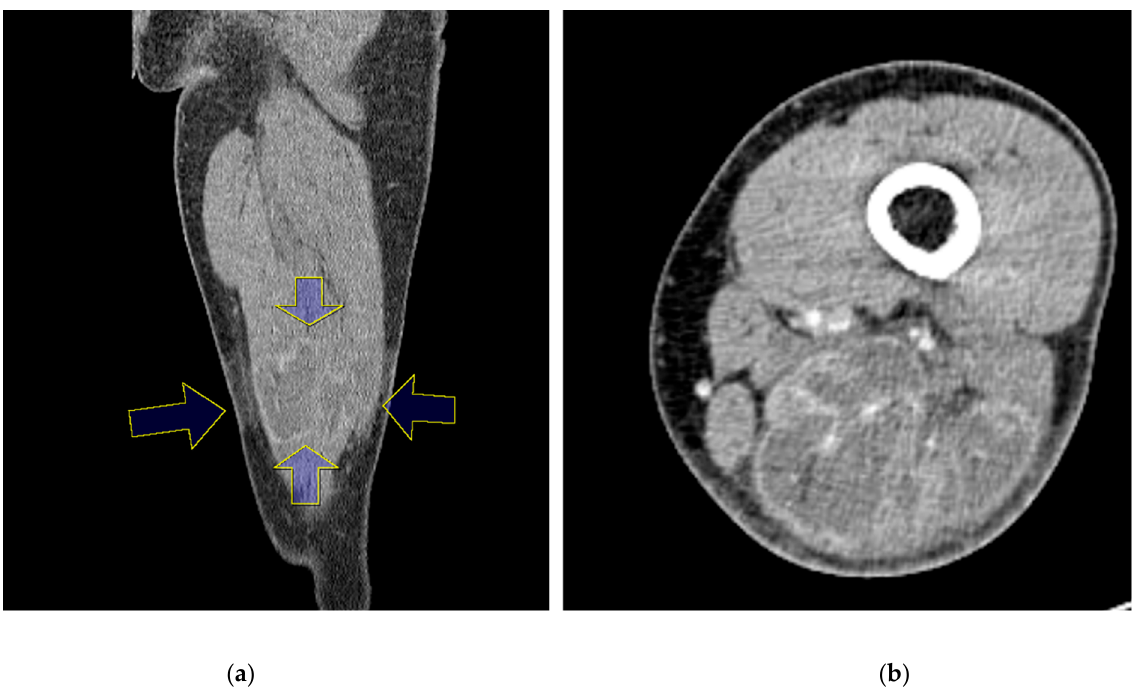
Figure 2. Computed tomography (CT) scan with contrast reveals ischemic changes in the adductor magnus, biceps femoris long and short head, semimembranosus, and semitendinosus muscles from 25 cm below the femoral head (blue arrow) in coronal view( a ) and axial view( b ). During outpatient follow-up, the patient’s foot drop showed no significant improve- ment, the sensory deficit was sustained, and severe tenderness with a visual analog scale (VAS) score of 7 was observed, along with a palpable mass in the posterior aspect of the left thigh. Despite conservative treatment, there was no improvement in pain or motor and sensory function. In addition, apparent muscle necrosis and sciatic neuropathy were observed in the imaging study; therefore, surgical intervention was